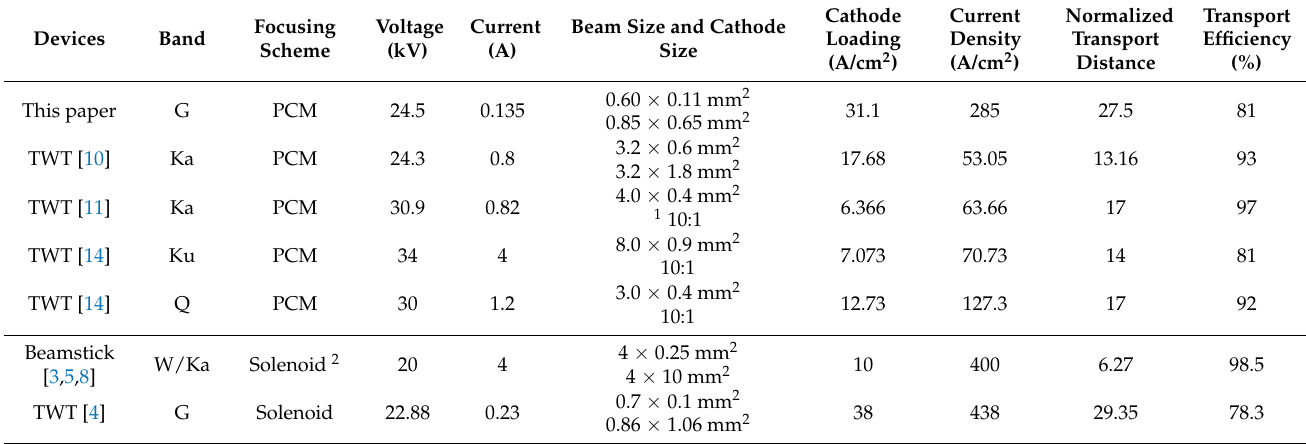
Table 3. Comparison of the electron optical parameters of the sheet-beam TWTs, which were reported with experimental